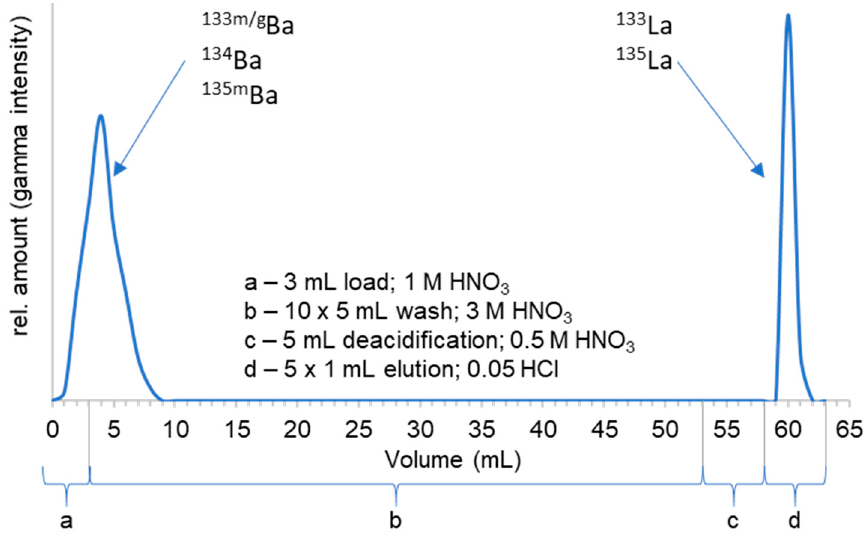
Figure 5. Elution profile of the Ba/La separation process using the DGA cartridge.